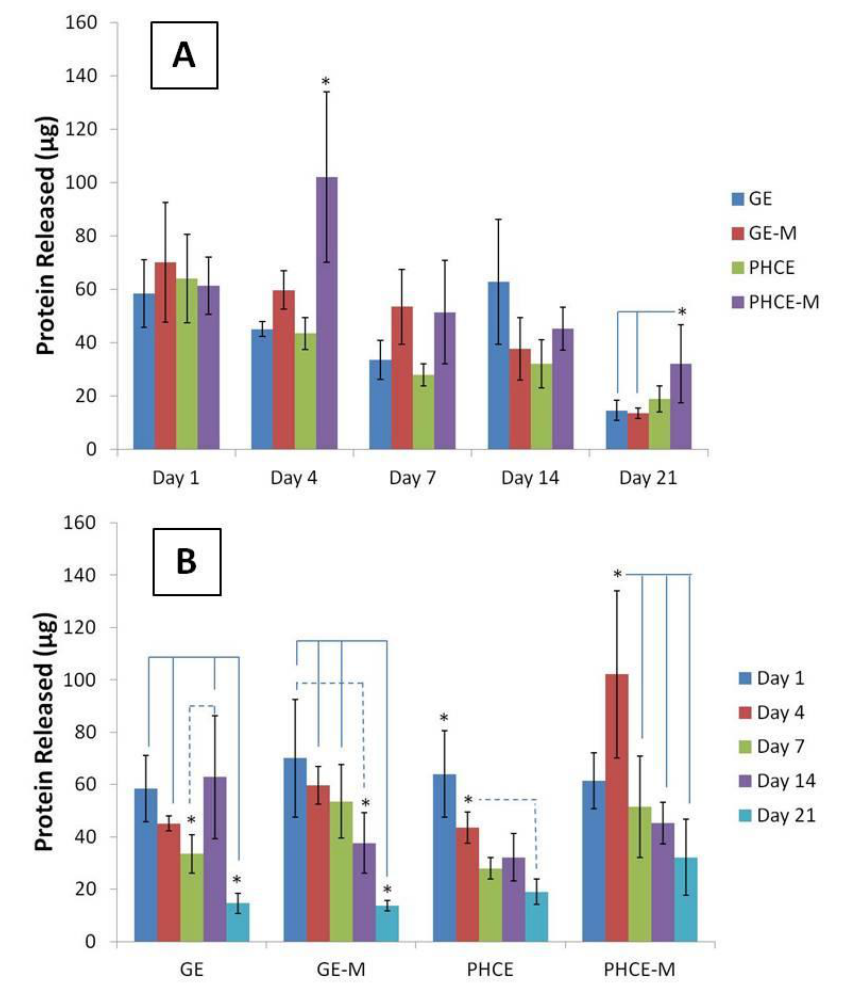
Figure 5. Comparison of protein released ( A ) by scaffolds at a given time point and ( B ) over time, specific to each scaffold. PHCE sponges released significantly more protein on days 4 and 21 compared to all other scaffolds. Overall, protein released from all scaffolds significantly decreased by day 21 suggesting the majority of release occurs at earlier time